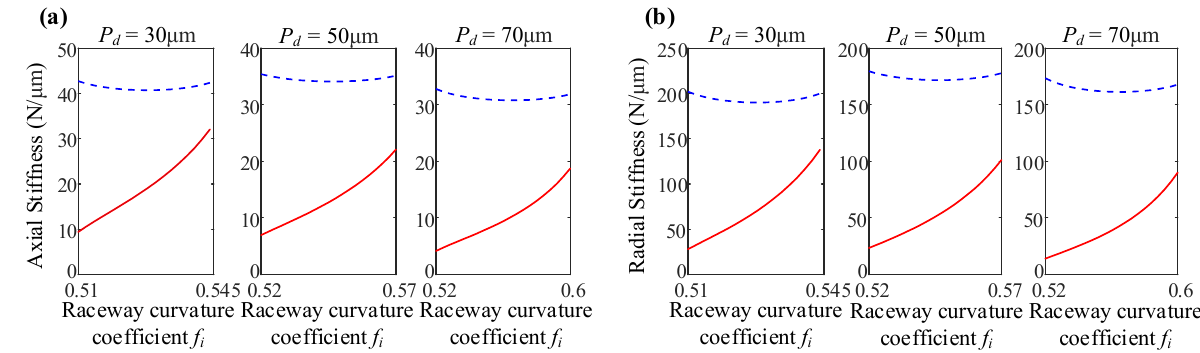
Figure 16. The influences of raceway curvature coefficient on bearing stiffness with different radial clearance and constant initial contact angle: ( a ) bearing axial stiffness varies with inner raceway curvature coefficient fi; ( b ) bearing radial stiffness varies with inner raceway curvature coefficient fi ( ------ rotating speed = 0 rpm, —— rotating speed = 20,000 rpm).